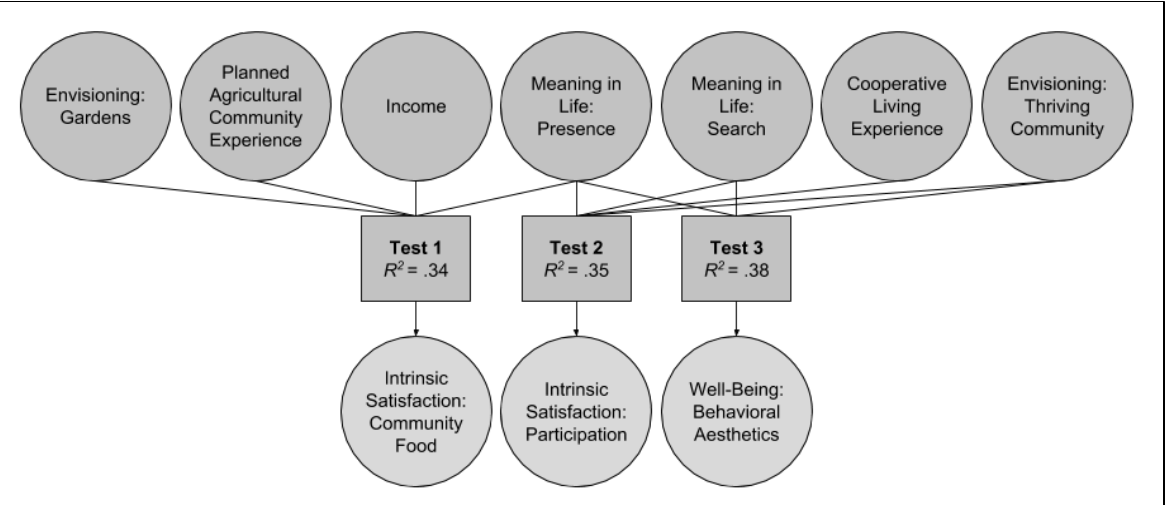
Figure 2. Diagram Outlining Regression Tests Described in the secton “ Additional Predictors of Intrinsic Satisfactions and Psychological